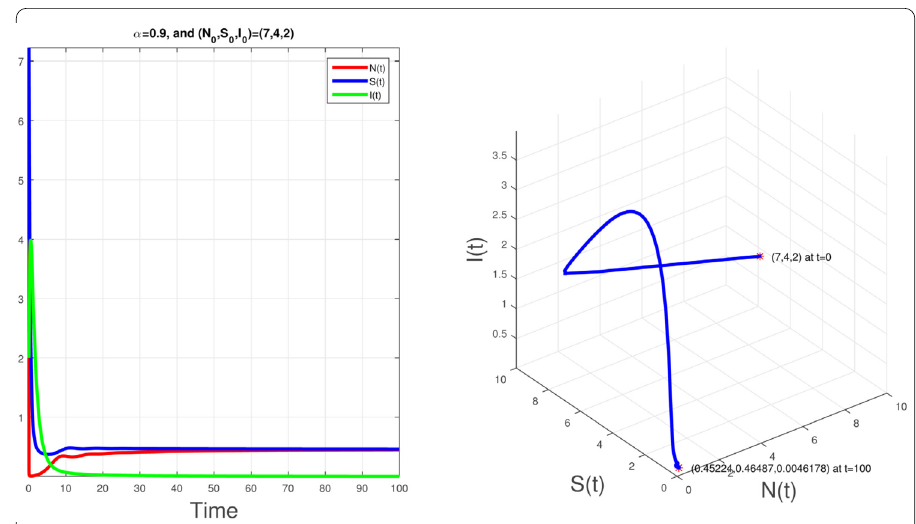
Figure 2 Influence of the hunting cooperation rate a on the existence of the DFE for the values r = 1.2, μ = 2.5, e = 0.8, λ = 0.02, k = 12.5, β = 3.5, η = 0.5